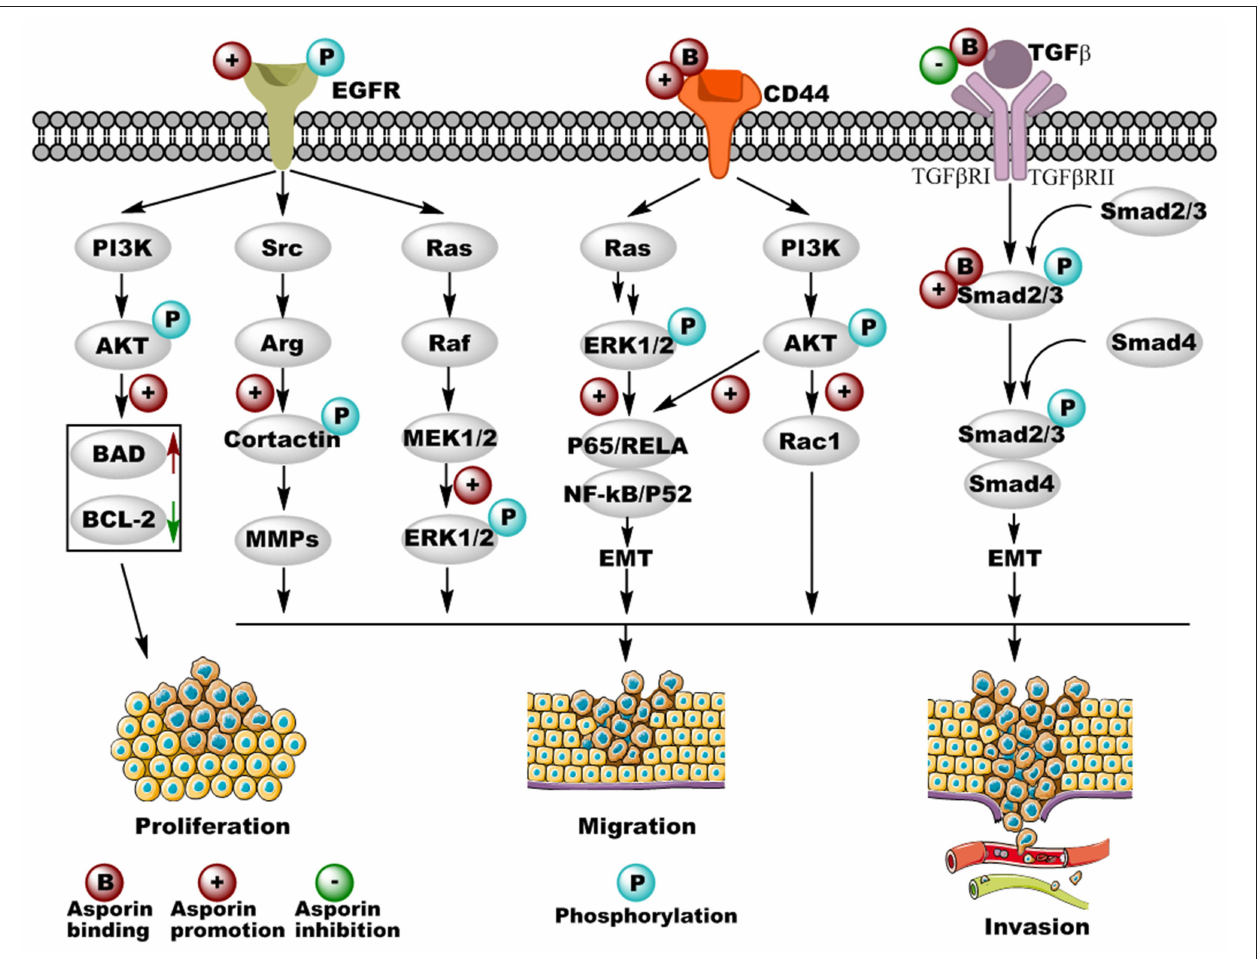
FIGURE 2 | Cancer-related pathways regulated by asporin in different types of cancer. Asporin not only promotes cancer cell proliferation, migration, and invasion by binding with CD44 and Smad 2/3 as well as promoting the phosphorylation of EGFR, but also inhibits cancer cell migration and invasion by binding with TGF- β in the extracellular matrix. Upregulated and downregulated proteins are shown in solid red and green arrows, respectively. Original elements used in this diagram are from Servier Medical Art